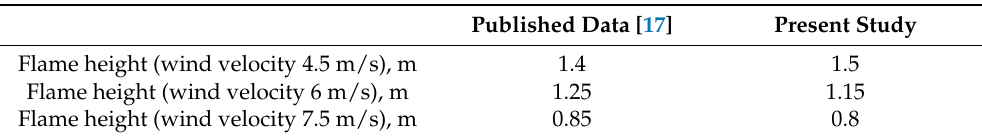
Table 1. Comparison of the flame height, as functions of the wind velocity, between published data [17] and the present study, for the fire intensity of 10